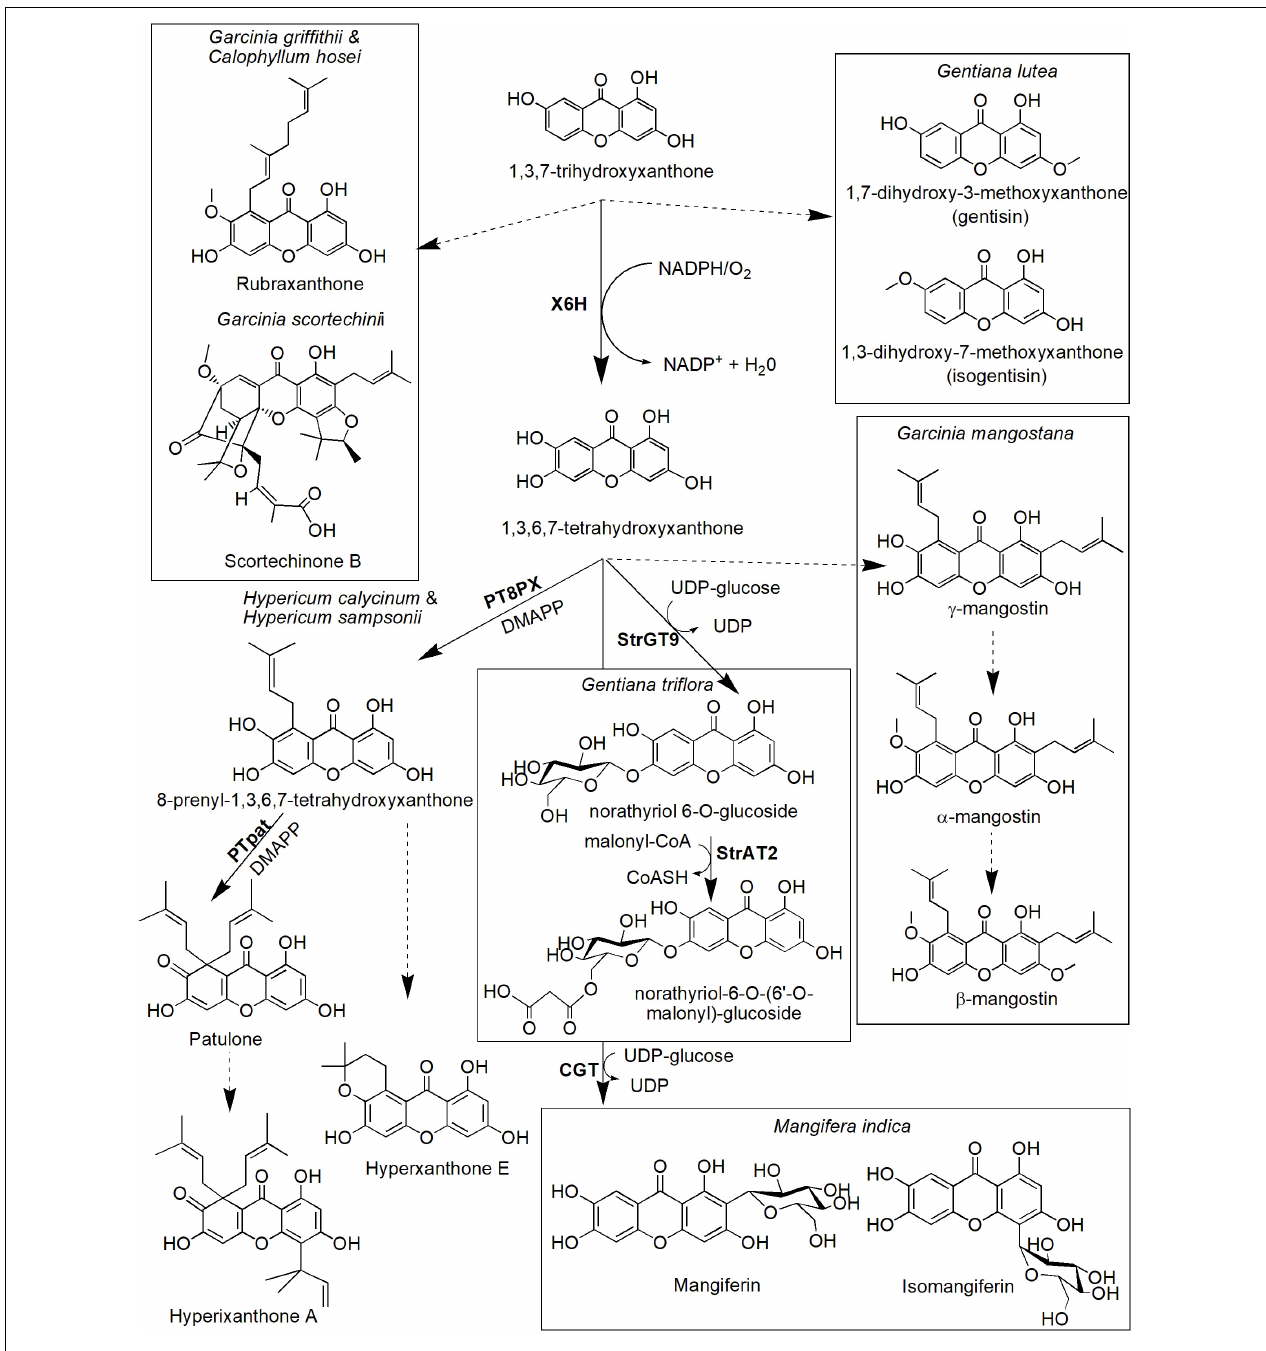
FIGURE 5 | Proposed biosynthetic pathways of several xanthone derivatives derived from 1,3,7-trihydroxyxanthone precursor. Dotted arrows indicate hypothetical/proposed pathways while protein activities detected at the molecular level are in bold (refer to Table 1 ). CoASH, coenzyme A; DMAPP, dimethylallyl pyrophosphate; PT8PX, 8-prenylxanthone-forming prenyltransferase; PTpat, patulone-forming prenyltransferase; StrAT2, malonyl-CoA acyltransferase; StrGT9, norathyriol 6-O-glucosyltransferase; UDP, uridine diphosphate; X6H, xanthone